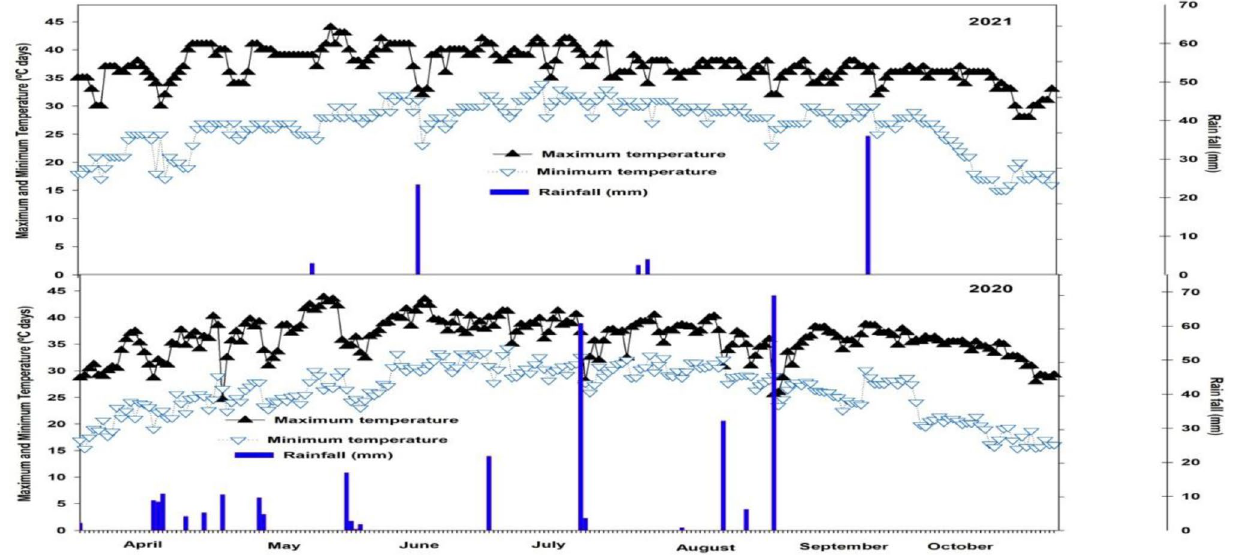
Figure 3. Weather data during the experimental period of cotton crop during both years 2020, and